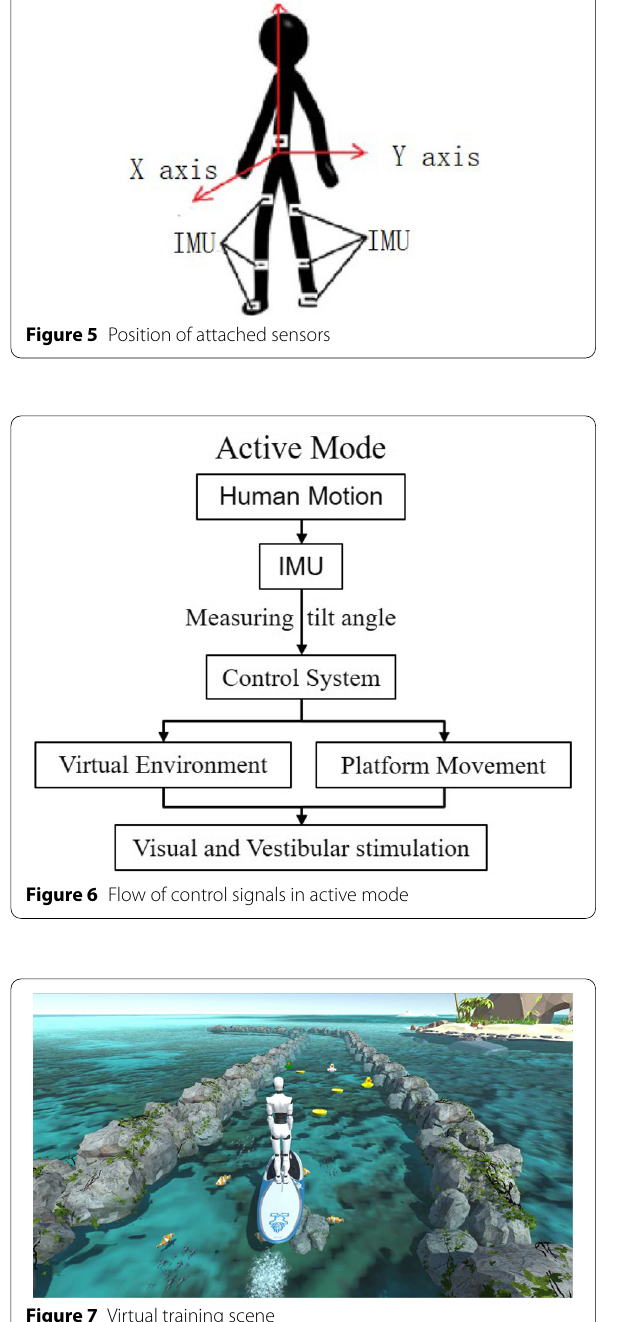
The flow of the control signals and one virtual training scene are shown in Figures 6 and 7, respectively. This scene is similar to a surfing game. The movement of the lower limbs of the human body corresponds to the change in the